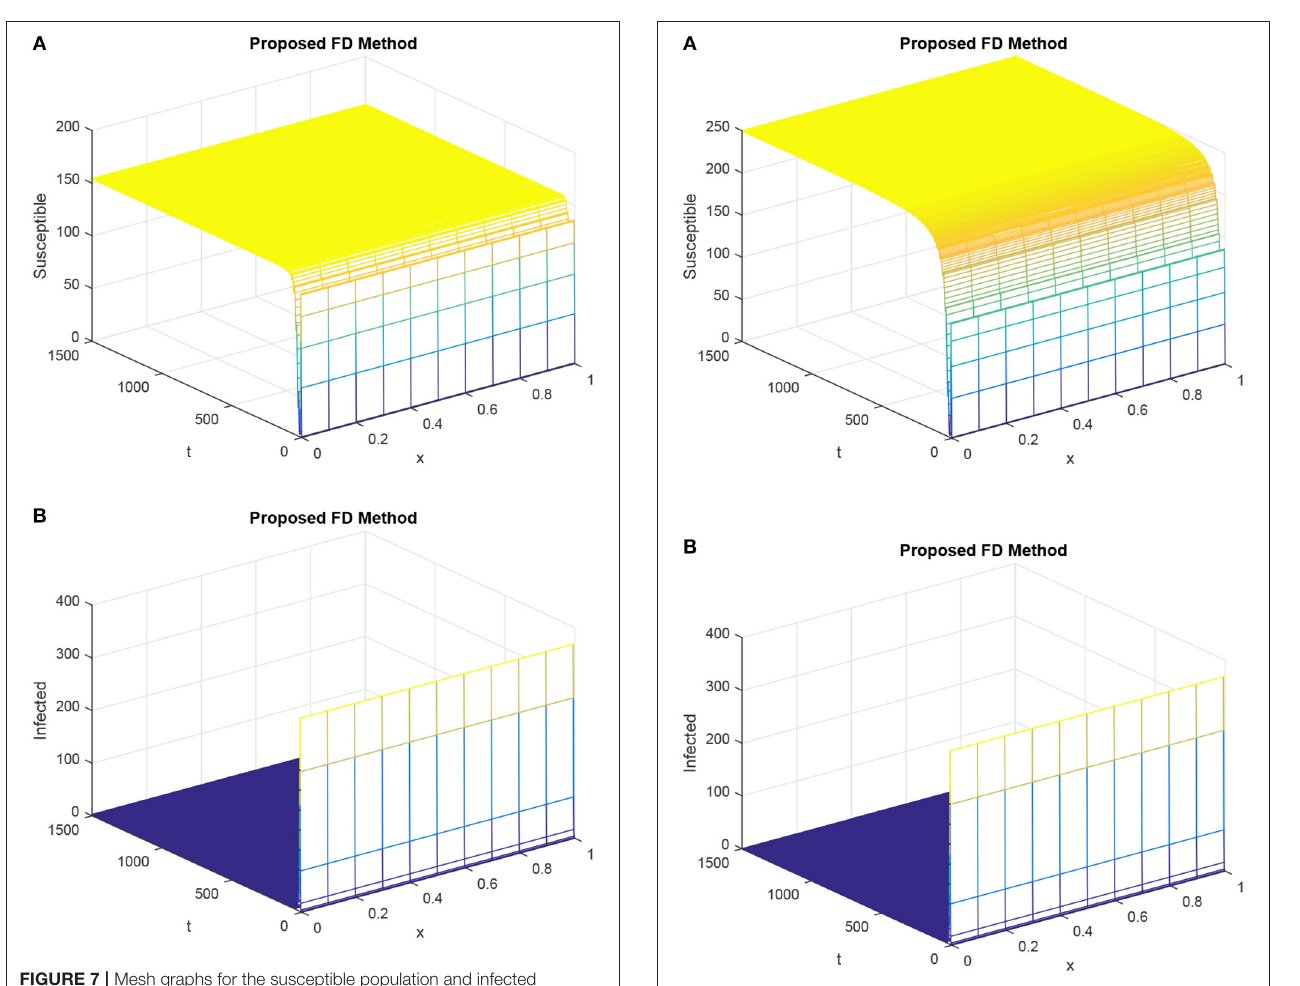
FIGURE 8 | Discretized graphs of the susceptible population and infected population for our designed FD scheme, giving h = 0.1 and R 1 = R 2 = 0.15, τ = 15. (A) Mesh graph of S . (B) Mesh graph of I